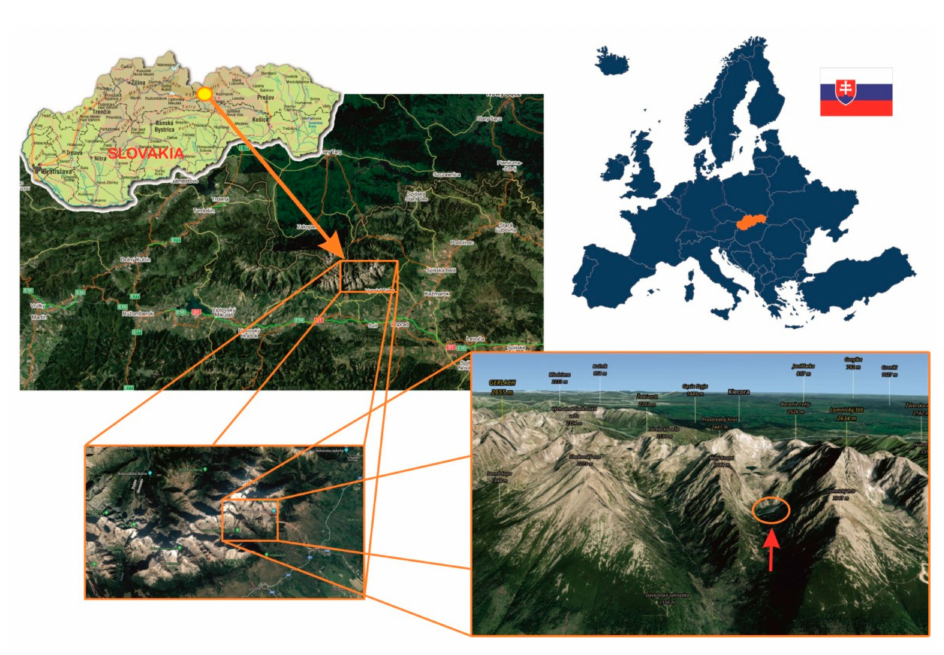
Figure 1. Location—Little Cold Valley in the High Tatras,